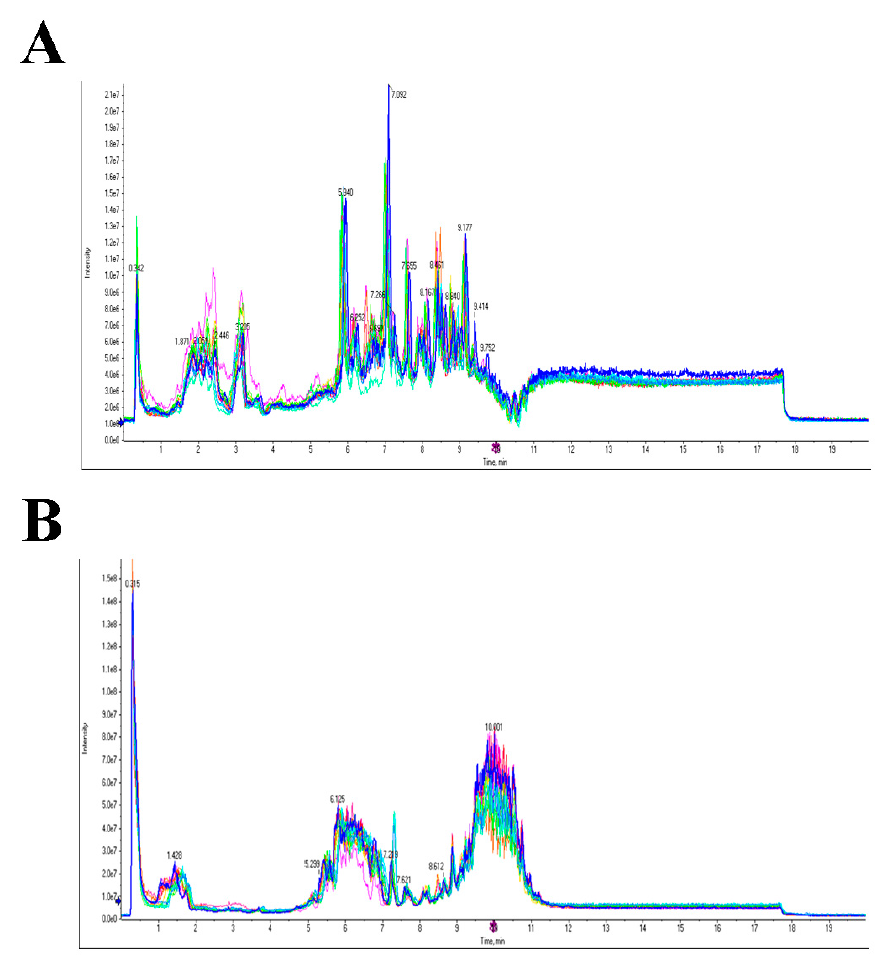
Figure A2. Overlay of the total ion chromatograms for the pooled tissue samples used as quality controls acquired on different days, showing the reproducibility of data acquisition on different days in ( A ) negative ESI ionization mode and ( B ) positive ESI ionization mode.